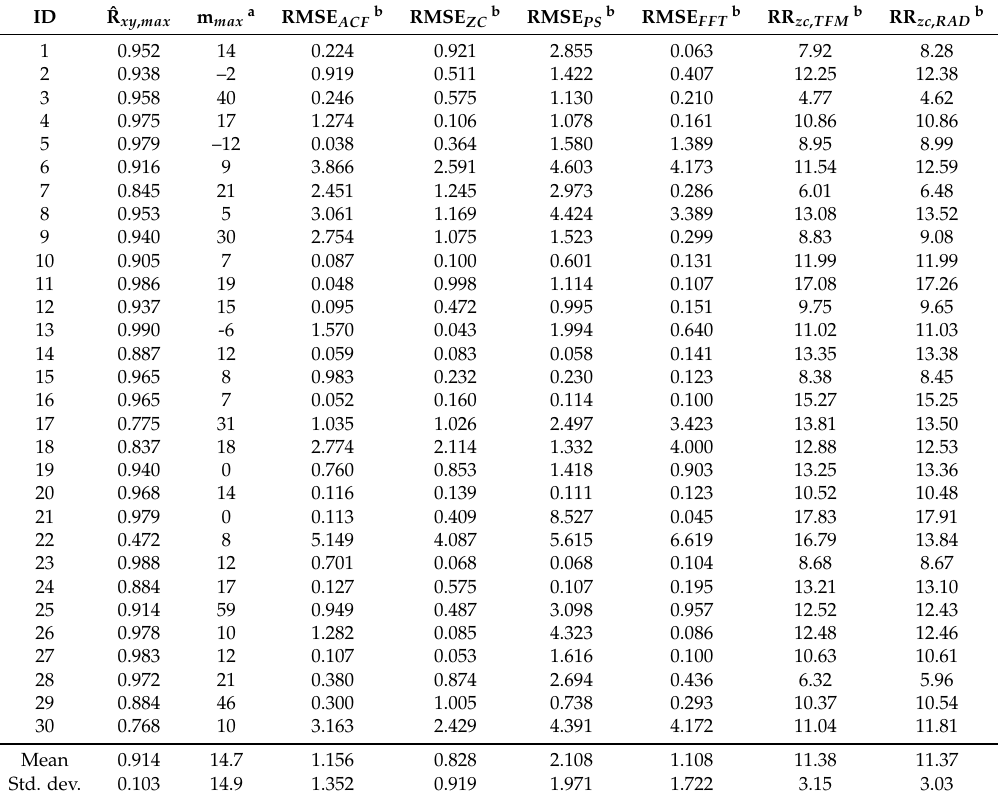
Table 1. Results of respiration analysis. Shown are the maximum correlation value and RMSE values of the four respiration rate determination methods. In addition, the respiration rates of the radar and reference signals are